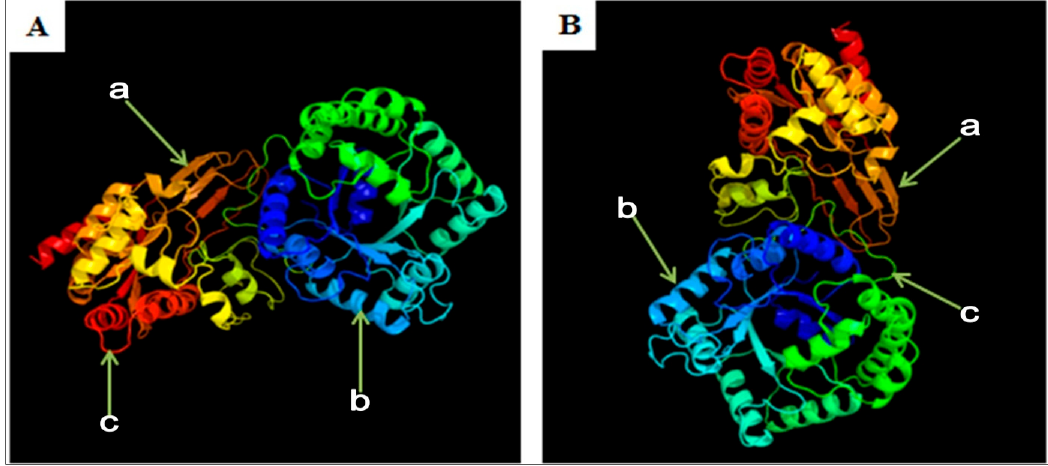
Figure 6. 3D structure of MTHFR protein; ( A ) yellow-cattle MTHFR; ( B ) human MTHFR. a, extended strand; b, alpha-helix; c, random coil